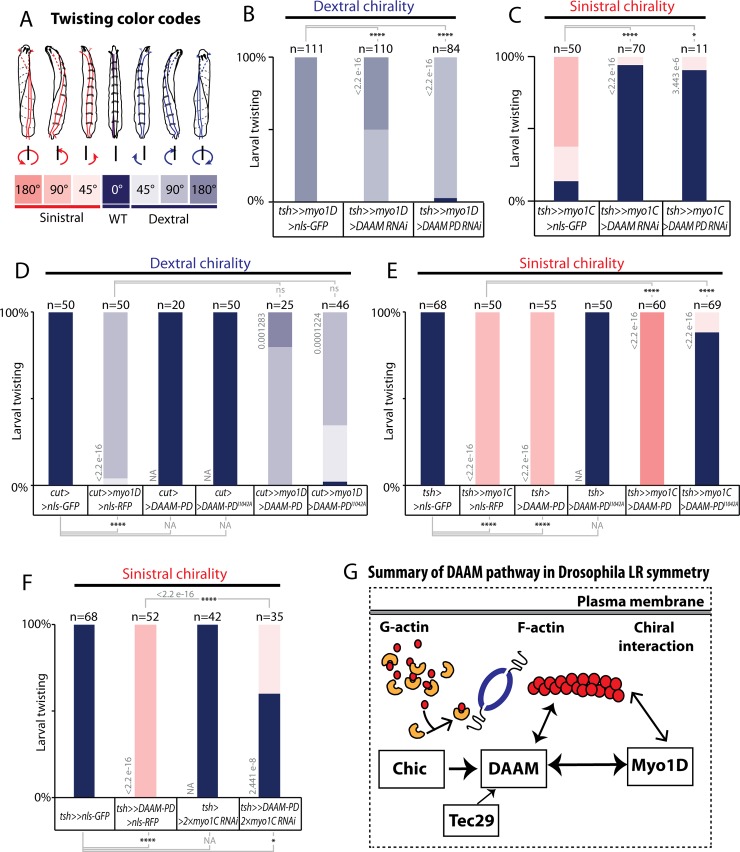
DAAM is essential for de novo LR asymmetry induced by Myo1D and Myo1C.A, Color code and schemes describing the extent of larval twisting described in B-F. Dextral and sinistral twisting is defined respectively as clockwise or anti-clockwise rotation of the anterior of the larvae when viewed from the anterior side. Anterior is up. B, Loss of DAAM function suppresses myo1D-induced de novo LR asymmetry. Removing DAAM function attenuates the myo1D phenotype.C, Loss of DAAM function suppresses myo1C induced de novo LR asymmetry. D, Overexpression of DAAM slightly enhances the myo1D-induced dextral twisted phenotype, while a form of DAAM that is mutant for nucleation (DAAM-PD-I1042A) does not. E, Overexpression of DAAM enhances the myo1C-induced sinistral twisted phenotype, while a form of DAAM that is mutant for nucleation (DAAM-PD-I1042A) does not. F, Loss of myo1C suppresses DAAM-induced twisting, indicating that the sinistral phenotype induced by DAAM alone is mediated through endogenous Myo1C. G, Summary of the Myo1D-DAAM pathway in Drosophila LR asymmetry. In B-F: Numbers in parenthesis on the right side of color bars indicate the number of individuals analyzed for each genotype; bars with different colors represent the percentage of occurrence of a given genitalia posture, as described in C. Numbers above bars indicate Wilcoxon rank sum test p-values. P-value threshold for significance of the difference between compared genotypes is defined as: *: <1e-5; **: <1e-8; ***: <1e-11; ****: <1e-14. NA: not applicable.